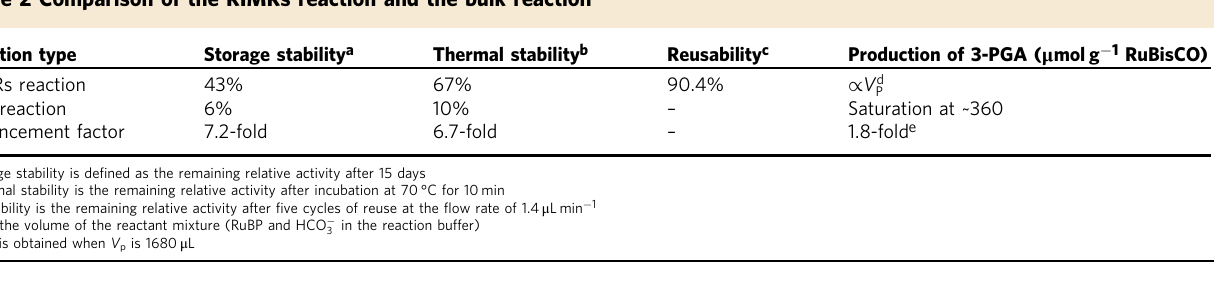
in the reaction buffer is 66 mM. Error bars 3